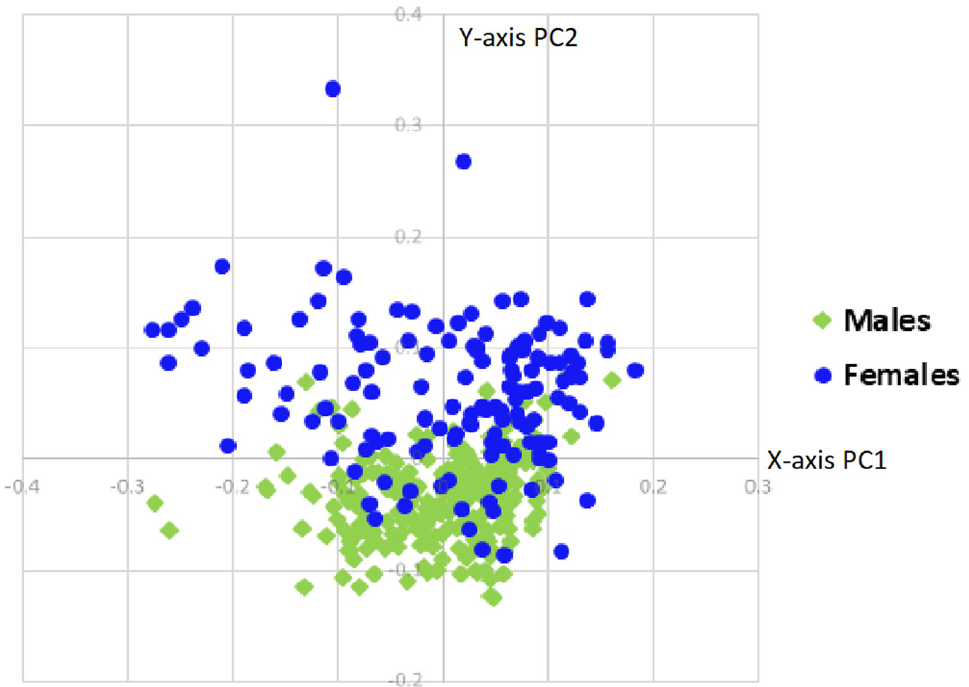
Fig 3. PCA scatter plot. PCA scatter plot displaying male and female